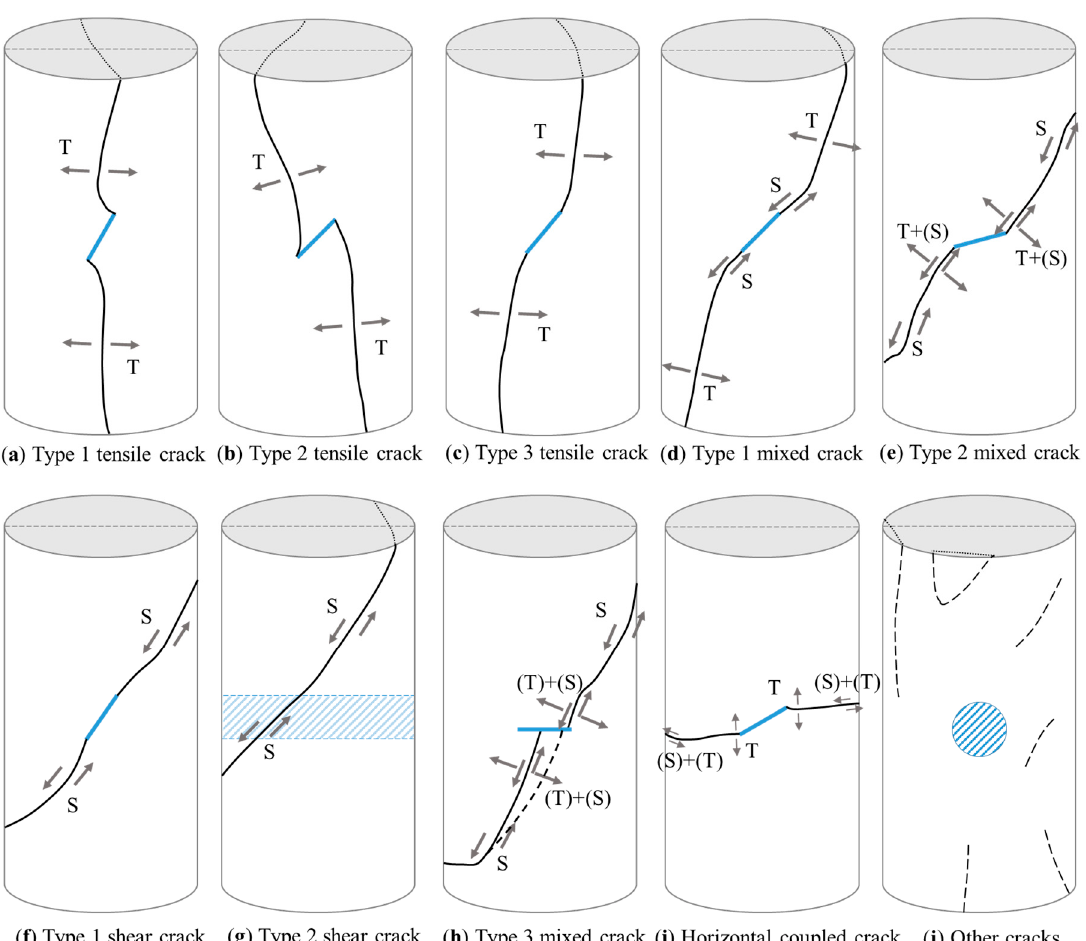
Figure 13. Crack types caused specimens failure in this study.